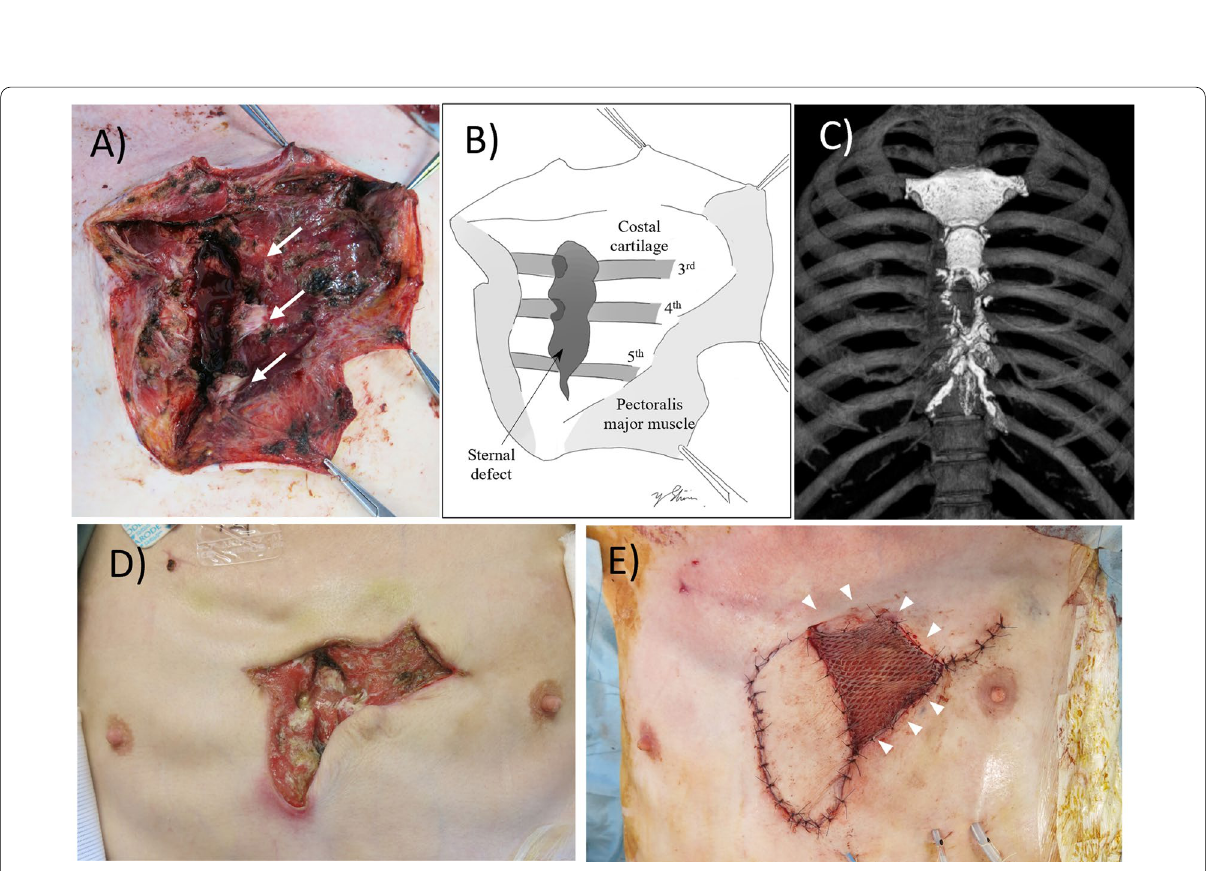
Fig. 3 The sternal resection followed by latissimus dorsi myocutaneous flap reconstruction. A , B The anterior chest wall was widely incised, and the caudal half of the sternal body was resected leaving the costal cartilage attachments. The arrows show third, fourth, and fifth costal cartilage from the top. Light gray area shows remaining pectoralis major muscle, which was widely debrided. C Postoperative CT image showing sternal defect. D , E The anterior chest wall wound before ( D ) and after ( E ) latissimus dorsi myocutaneous flap reconstruction (arrows) combined with meshed split-skin graft